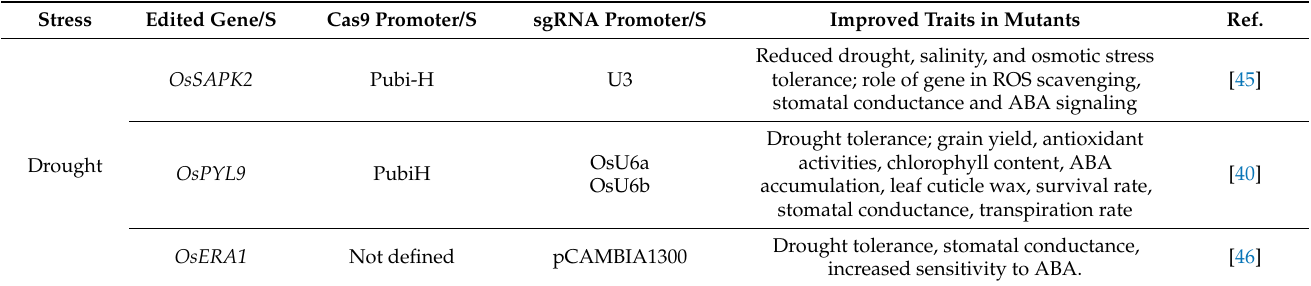
Table 2. Examples of CRISPR/Cas9 system for enhancing abiotic stress tolerance of